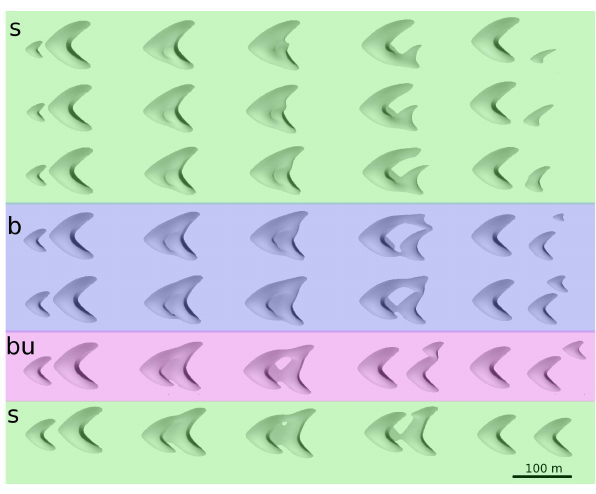
Fig. 6. (Color online) Snap shots of the time evolution of binary collision for θ i = 0 . 2 and volume ratios (from top to bottom): r i = 0 . 06, 0 . 08, 0 . 12, 0 . 17 and 0 . 3. Letters and colors distinguish the different results after collision. Notice that the smallest volume ratio r i = 0 . 06 used for the set of simulations, is large enough to avoid dune